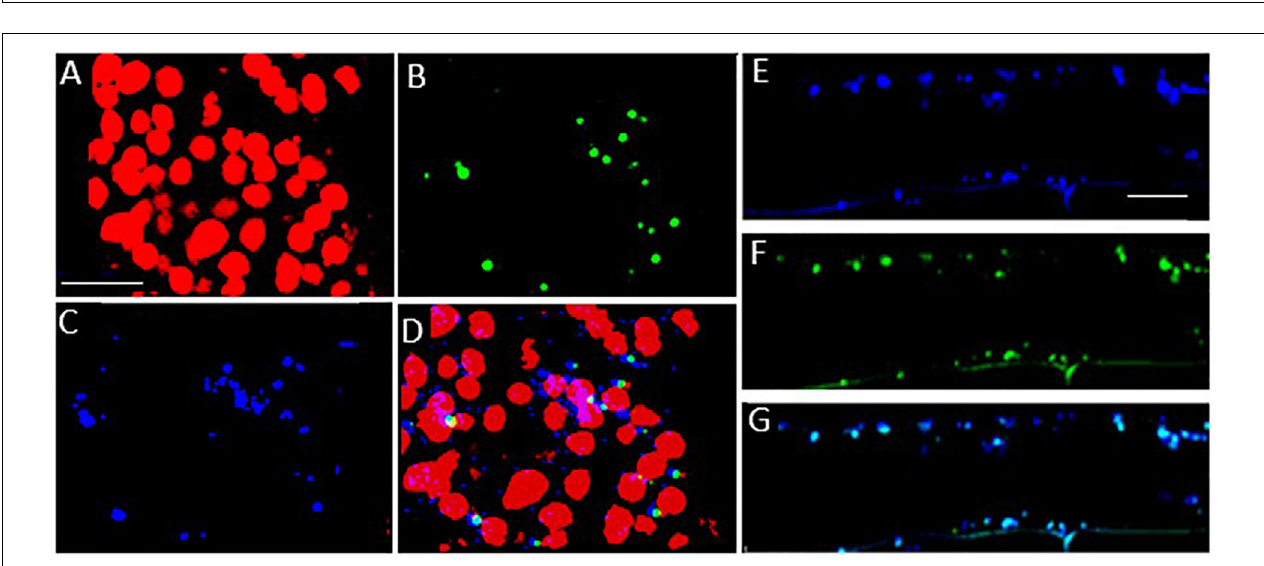
FIGURE 8 | Subcellular localization of the Arabidopsis LEA5 in barley leaves and roots. Confocal microscopy of 5-day old transgenic barley leaves (A–D) and roots (E–G) expressing the 35S-LEA5-YFP fusion protein. Chlorophyll autofluorescence is shown in red (A,D) , YFP signal is in green (B,F) , MitoTracker Red CMXRos is in blue (C,E) . (D and G) are merged images of (A–C,E,F) , respectively. All scale bars are set to 10 µ